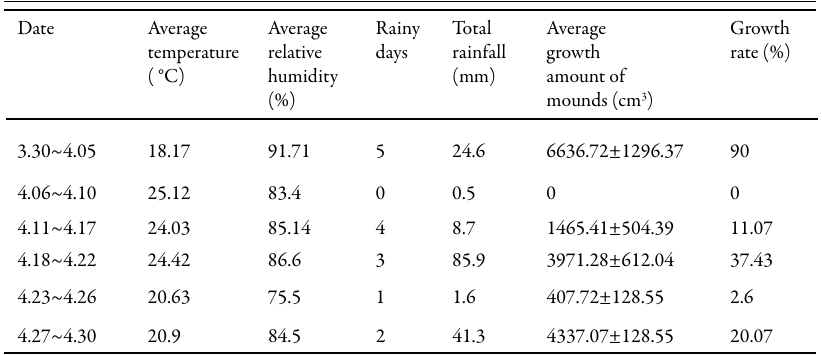
table 1 The relationship between mound growth and major climatic factors.